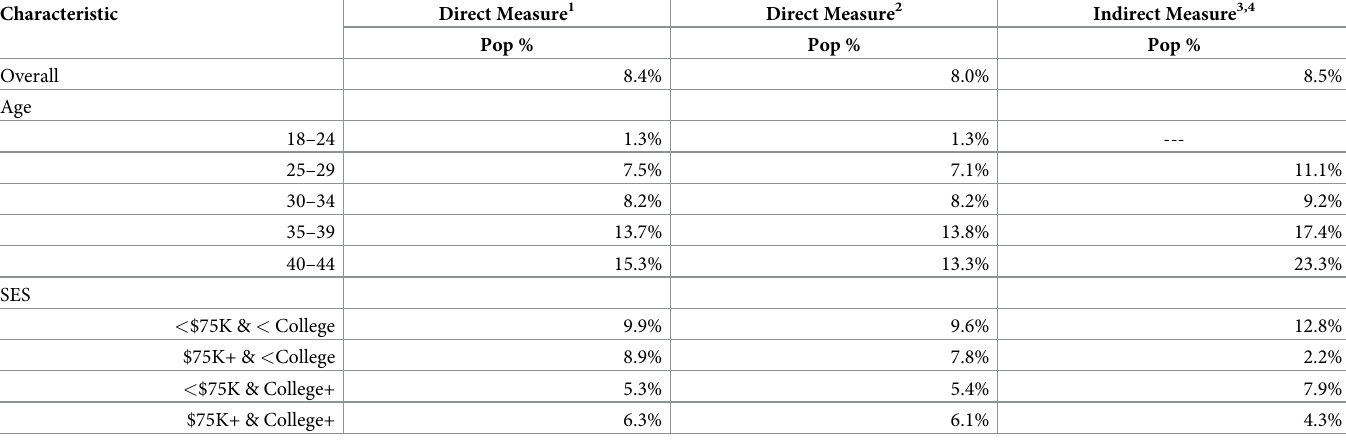
Table 3. Precent of the population that report abortion utilization by direct and indirect measures and by age and socioeconomic status, the Ohio Survey of Women (n = 2529).